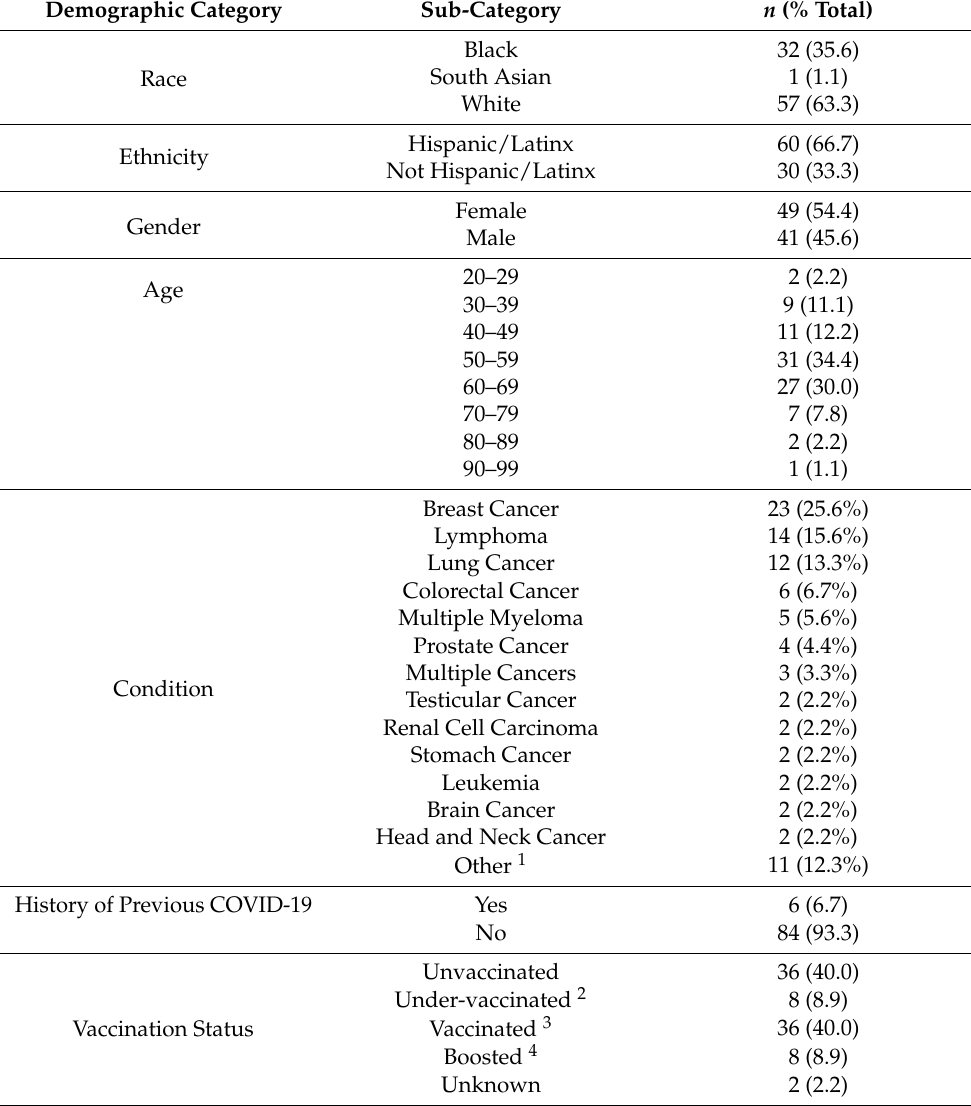
Table 2. Demographics of Patients ( n = 90) whom Tested Positive for